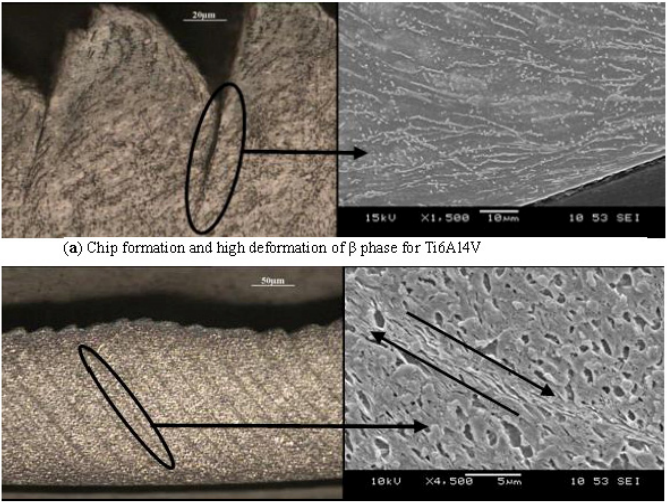
Figure 14. Microstructure of the chip material obtained after